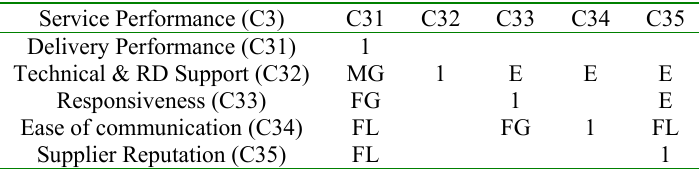
Table 11. Linguistic evaluation matrix of DM1 for C3 sub-criteria